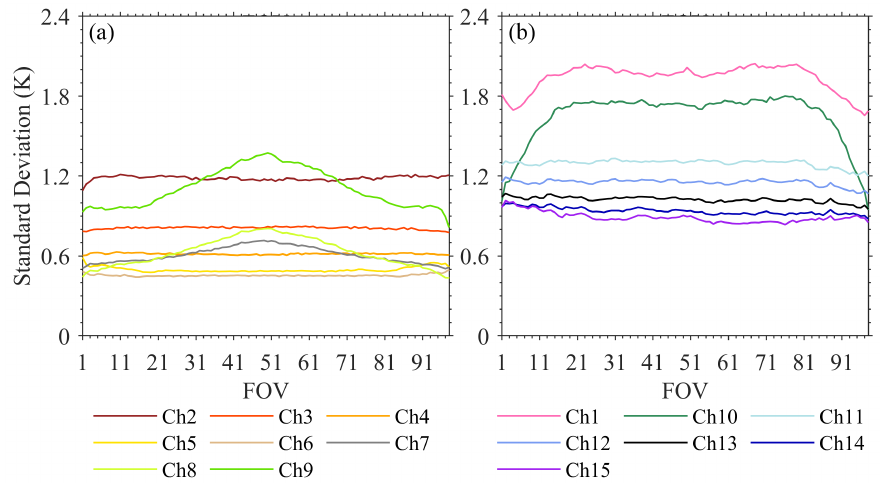
Figure 14. The standard deviations of “O − B” (unit: K) varying with the FOVs for ( a ) the 118-GHz channels and ( b ) the other channels after removing the along-scan